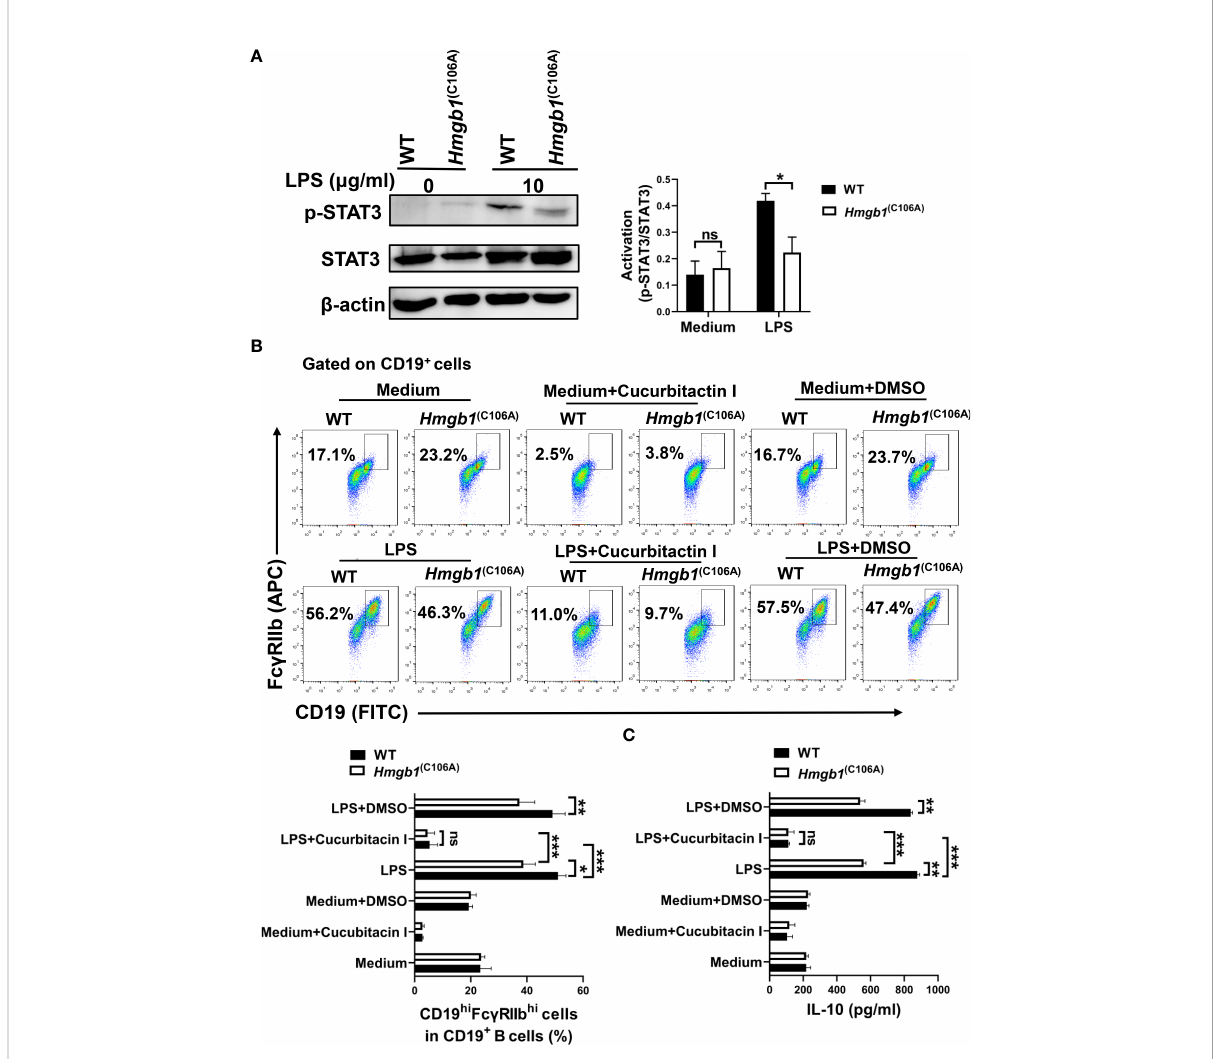
FIGURE 5 Hmgb1 (C106A) inhibits STAT3-mediated expansion and function of CD19 hi Fc g RIIb hi B cells. (A) Splenic CD19 + B cells sorted from Hmgb1 (C106A) or WT mice were cultured with or without LPS. After 2 days, total proteins were extracted from B cells, and STAT3 phosphorylation was determined by Western blotting. Data are shown as means ± SEMs of three independent experiments. (B) CD19 + B cells (2 × 10 5 /well) sorted from Hmgb1 (C106A) or WT mice were treated with LPS in the presence or absence of cucurbitacin I or dimethyl sulfoxide in 96-well plates. After 2 days, B cells were collected and subjected to fl ow cytometry to assess the percentage of CD19 hi Fc g RIIb hi B cells. Data are shown as means ± SEMs of three independent experiments. (C) CD19 + B cells (2 × 10 5 /well) sorted from Hmgb1 (C106A) or WT mice were treated with LPS in the presence or absence of cucurbitacin I or dimethyl sulfoxide in 96-well plates. After 2 days, supernatants were collected for measurement of IL-10 levels by ELISA. Data are shown as means ± SEMs of three independent experiments. *P < 0.05; **P < 0.01; ***P < 0.001; NS, not signi fi